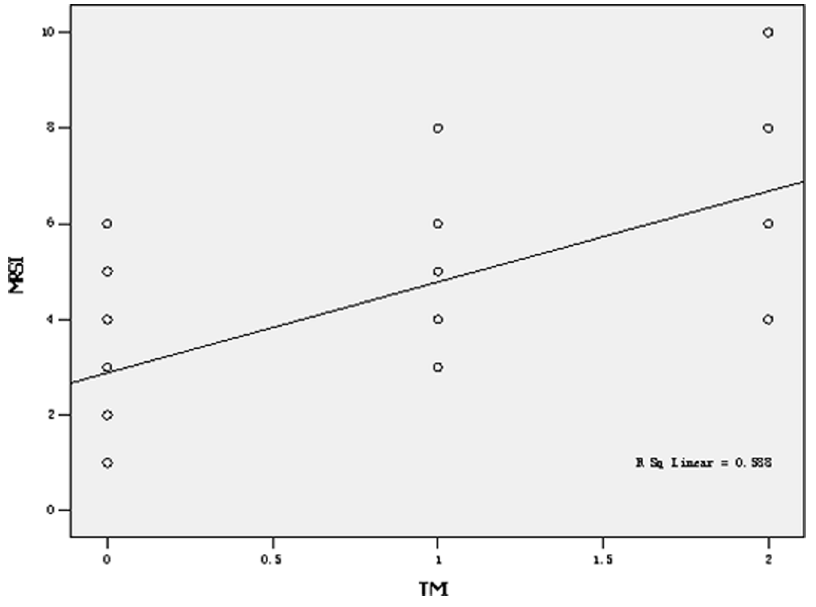
Figure 8. Spearman’s correlation between the MRSI and TMI (r=0.759, P=0.000). doi:10.1371/journal.pone.0093687.g008 PLOS ONE |